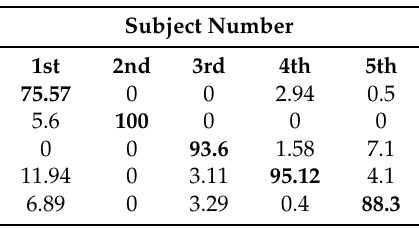
Table B3. The Confusion matrix using DFA classifier after artifact removal for the 2 chosen features (1 joint ratio, 1 joint